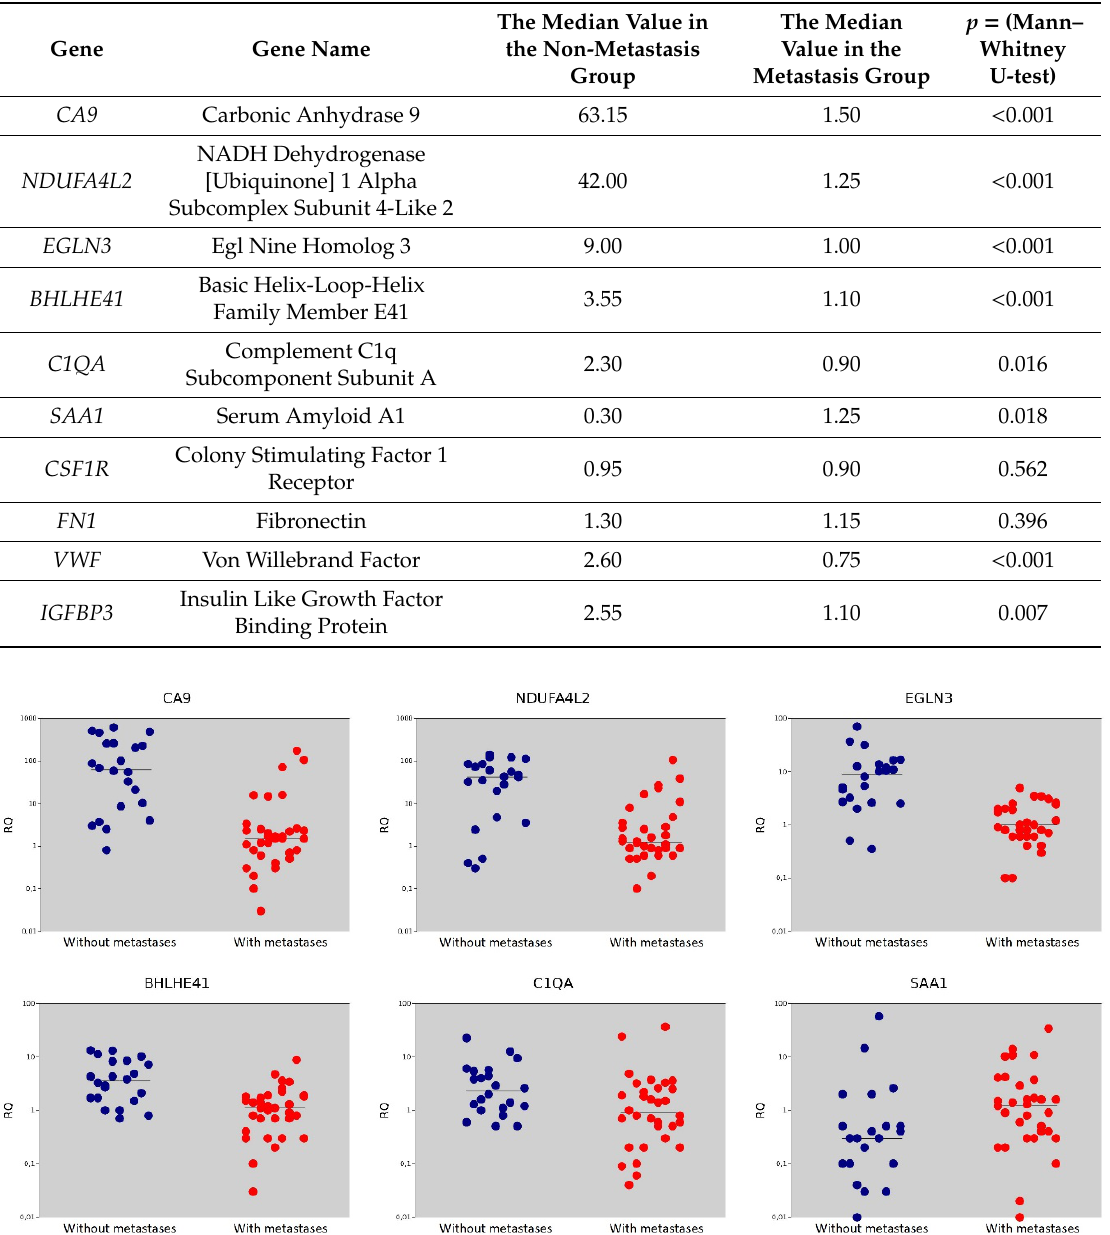
Table 1. The values of the medians and the significance of their differences in the ccRCC groups of with and without metastases.